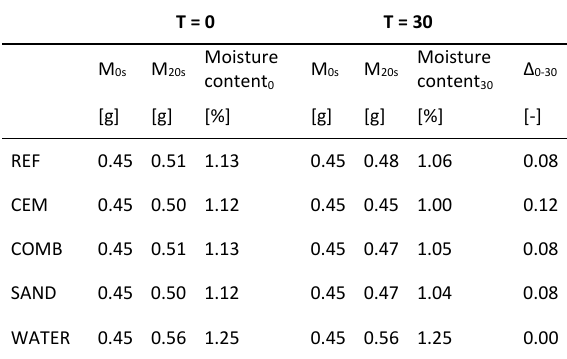
Table2. Moisture content at different time gaps and surface modification techniques.